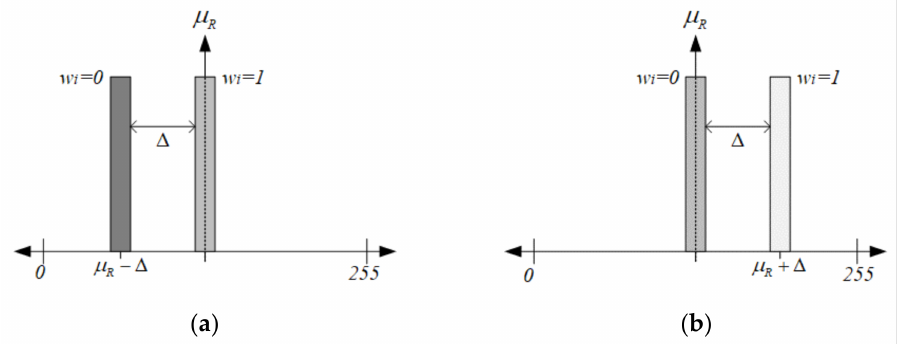
Figure 7. Histogram distortion of the watermarked region, ( a ) Histogram distortion induced by Equation (13), ( b ) Histogram distortion induced by Equation (14).